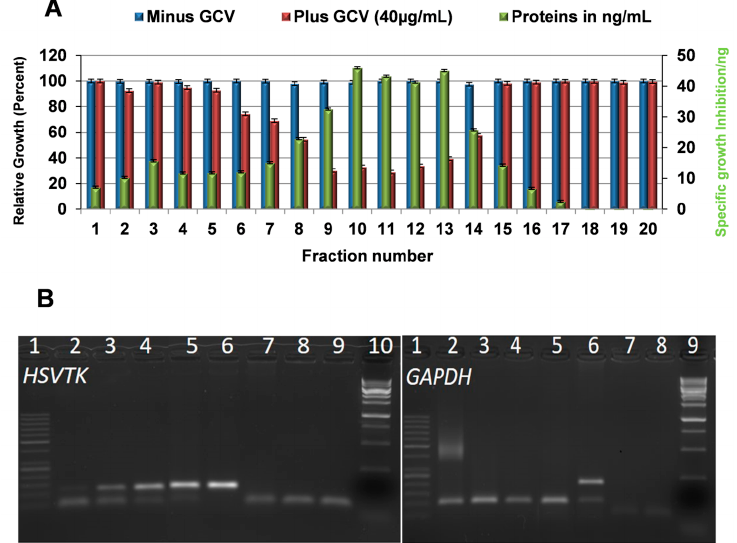
Figure 4. Assessment of glioblastoma cell growth inhibition activity by exosomes with mRNA of HSVTK in their cargo. ( A ) Elution profile of CM fractionated by the size-exclusion chromatography in a Sepharose CL-4B column. Each fraction was tested for tumor cell growth (absence GCV) and tumor cell growth inhibition (presence GCV). Relative growth inhibition to protein presence was calculated. ( B ) RNA isolated from exosomes of the HSVTK gene transduced UC-MSCs was reverse transcribed (RT) and HSVTK and GAPDH cDNA was PCR amplified. Presence of mRNA of HSVTK gene specific transcripts was visualized by 2% agarose gel electrophoresis. HSVTK -RT-PCR gel: (1) O’RangeRuler 50 bp DNA Ladder; (2) exosomal RNA of MSC (RT with oligo (dT) 18 primer s ); (3) exosomal RNA of UC-MSC (RT using random hexamers); (4) total RNA HSVTK -MSCs (mRNA HSVTK positive control); (5) total RNA HSVTK -melanom cells (mRNA HSVTK positive control); (6) plasmid pAPtk (PCR HSVTK positive control); (7) human genome DNA (PCR negative control); (8) RT reaction mixture with no RNA in reverse transcription (NTC); (9) PCR reaction mixture with no DNA in mixture (NTC); (10) 1 kb DNA ladder Solis; GAPDH RT-PCR gel: (1) O’RangeRuler 50 bp DNA Ladder; (2) exosomal RNA of MSC (RT with oligo (dT) 18 primer s ); (3) exosomal RNA of MSC (RT using random hexamers); (4) total RNA HSVTK -MSCs (mRNA HSVTK positive control); (5) total RNA HSVTK -uveal melanoma cells (mRNA HSVTK positive control); (6) mixture of genome DNA and cDNA of HSVTK -MSCs (RT-PCR and PCR positive control); (7) RT reaction mixture with no RNA in reverse transcription (NTC); (8) PCR reaction mixture with no DNA in mixture (NTC); (9) 1 kb DNA ladder Solis.